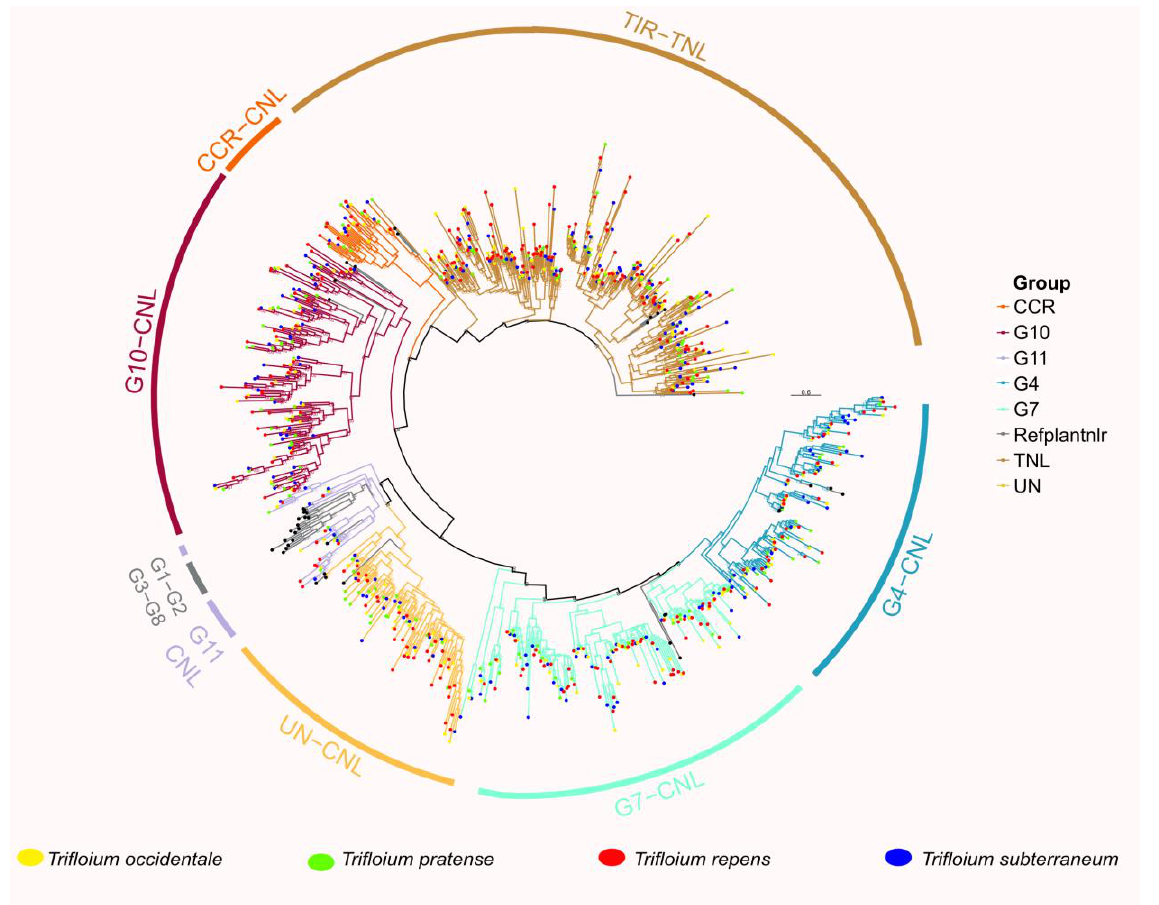
Figure 3. Phylogenetic reconstruction of NLR genes on the basis of conserved domain NB-ARC. Seven subgroups of NLR genes were identified in four species: T. occidentale , T. pratense , T. repens and T. subterraneum.